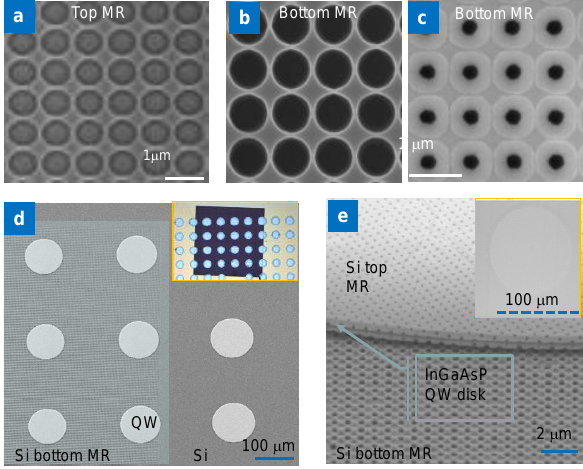
Figure 10. SEM images and micrographs of membrane reflector (MR) and MR-VCSEL. ( a ) Top MR transfer printed on glass; ( b ) Bottom MR on SOI substrate; ( c ) PECVD coated SiO2 on bottom MR; ( d ) InGaAsP QW disks/mesas transferred onto a bottom MR. An optical image is shown in the inset; ( e ) A complete MR-VCSEL device, showing the InGaAsP QW disk sandwiched in between top and bottom Si MRs. Additionally shown in the inset is a SEM top view of InGaAsP QW disk underneath large top Si MR layer Reproduced with permission from